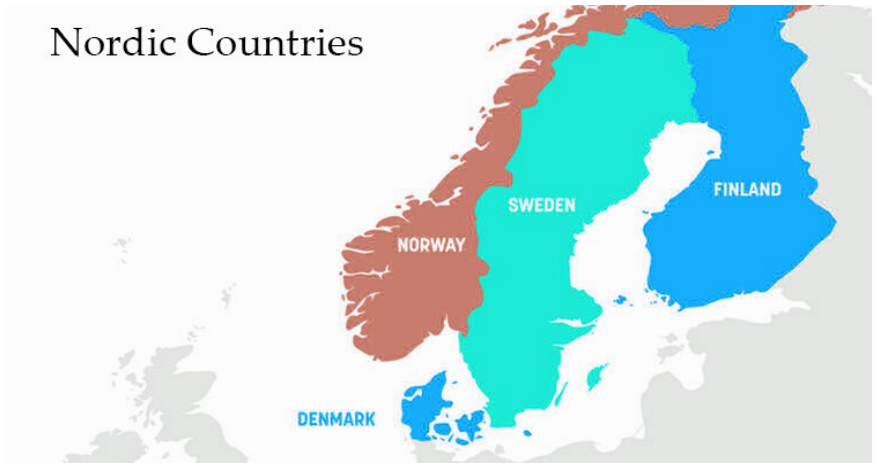
Figure 1. Area of the study map. Source: (Google maps).